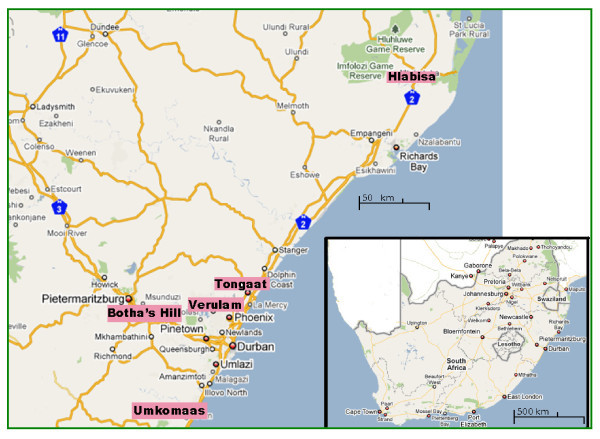
Study locations.